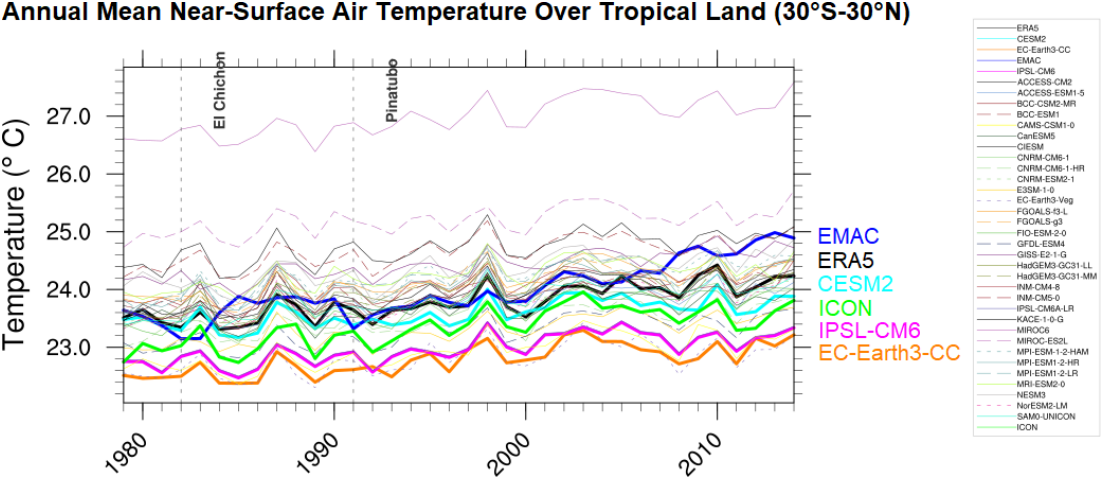
Figure 8. Example of an analysis of native model output alongside CMIP data and reanalysis products with ESMValTool’s wide range of diagnostics, similar to Fig. 1 of Bock et al. (2020). Annual near-surface air temperature between 1979 and 2014 averaged over tropical land region (30 ◦ S–30 ◦ N) for an ensemble of (CMORized) CMIP6 models (thin lines), the ERA5 reanalysis (thick black line), and the models presented in this paper for which a CMOR-like reformatting is available (CESM2: thick cyan line; EMAC: thick blue line; ICON: thick green line; IPSL-CM6: thick magenta line; EC-Earth3-CC: thick orange line). Vertical dashed lines show large volcanic eruptions. For all CMIP6 models and the native output of the models CESM2, EC-Earth3-CC, ICON, and IPSL-CM6, results of an AMIP simulation as defined by CMIP6 (Eyring et al., 2016) are used. The EMAC results shown here are based on a free running EMAC simulation following the CCMI-1 protocol that also uses prescribed sea surface temperatures and sea ice concentrations but a different set of forcings (Jöckel et al., 2016). Due to different model setups, a fair comparison of the individual models is not